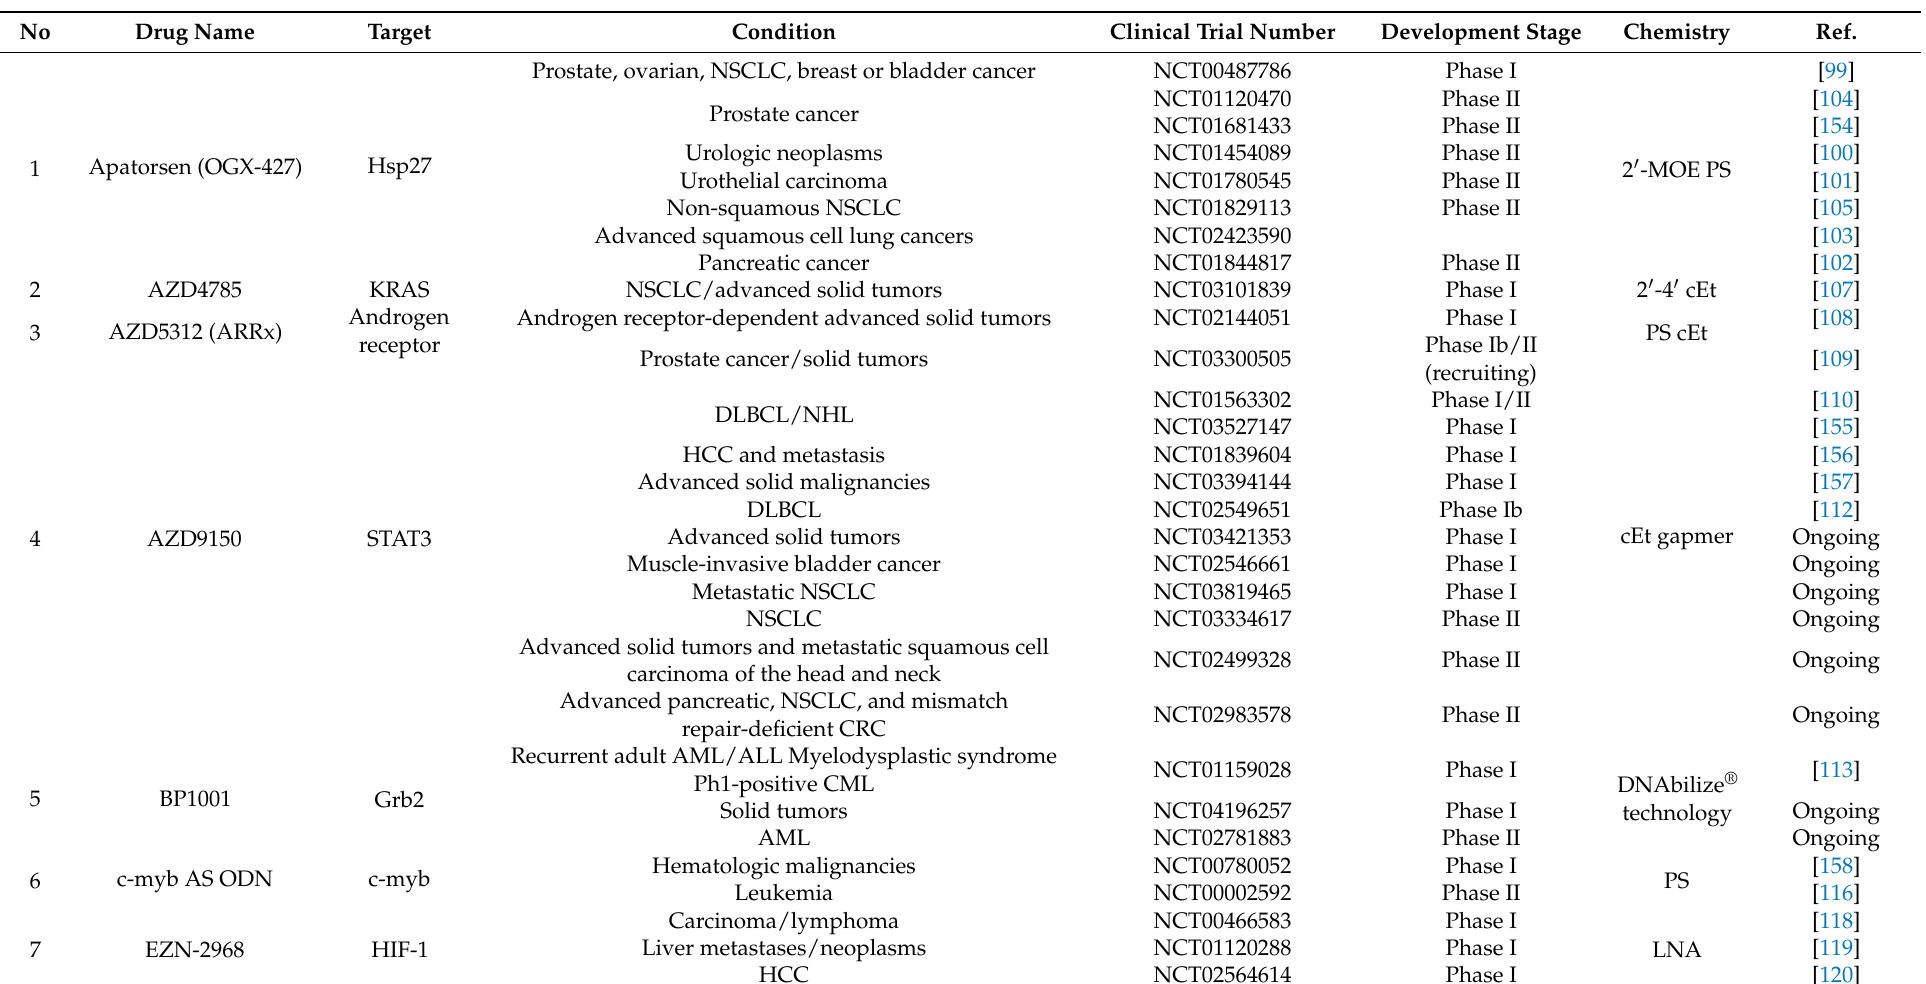
Table 2. List of antisense oligonucleotides in clinical